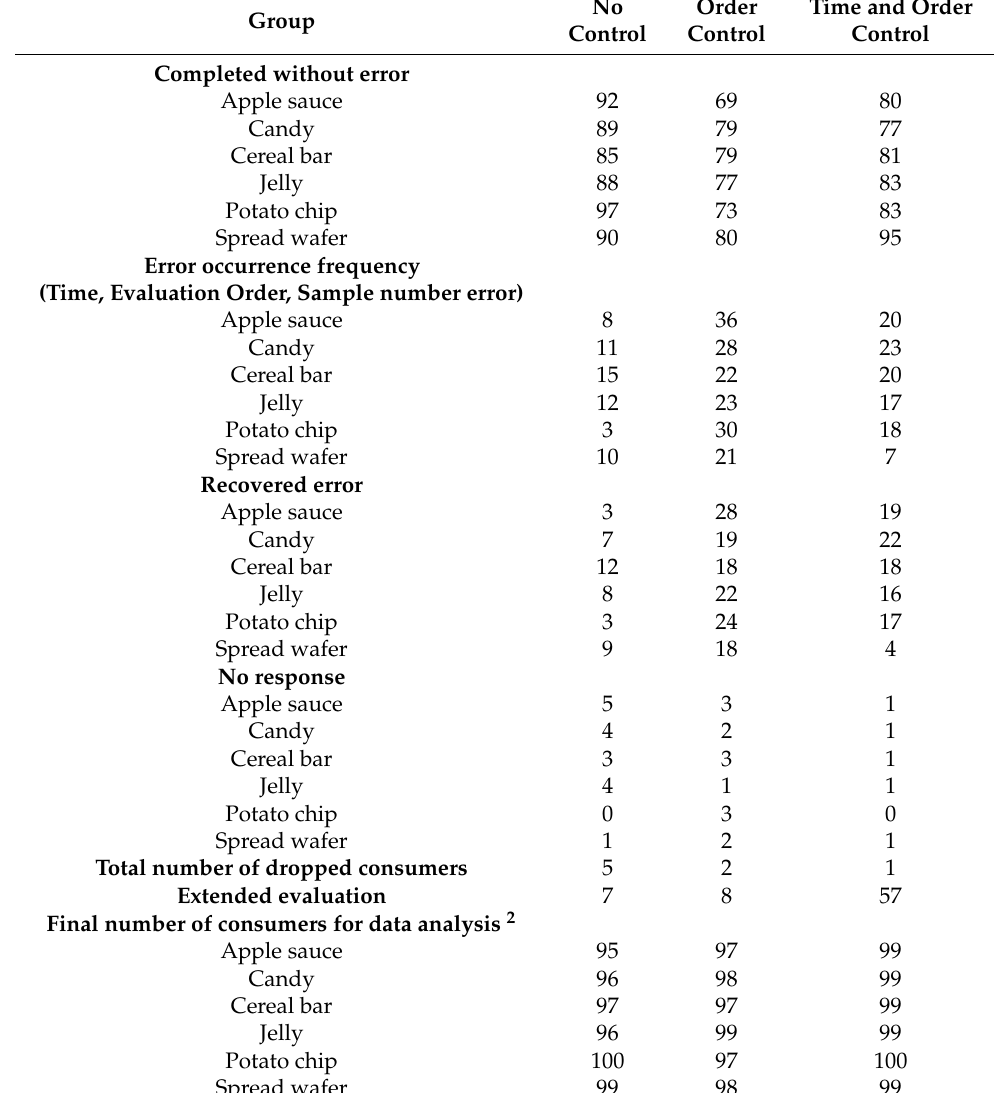
Table 3. Frequency of available data used, complete data and error data that were modifiable in each group 1